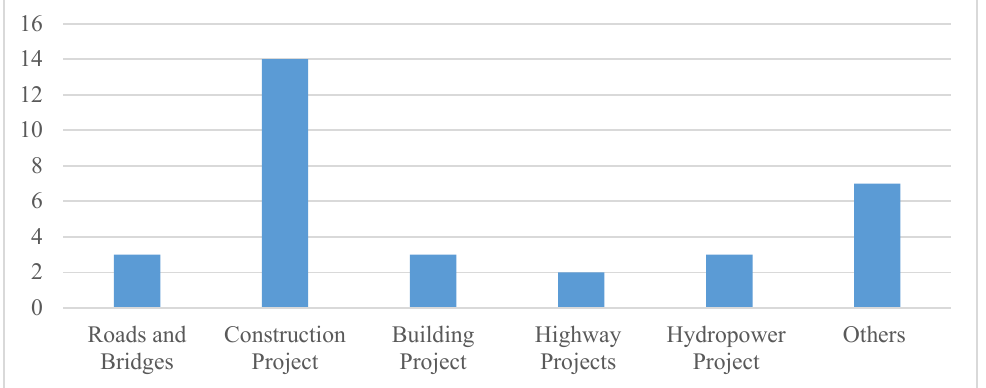
Fig. 3. Types of infrastructure